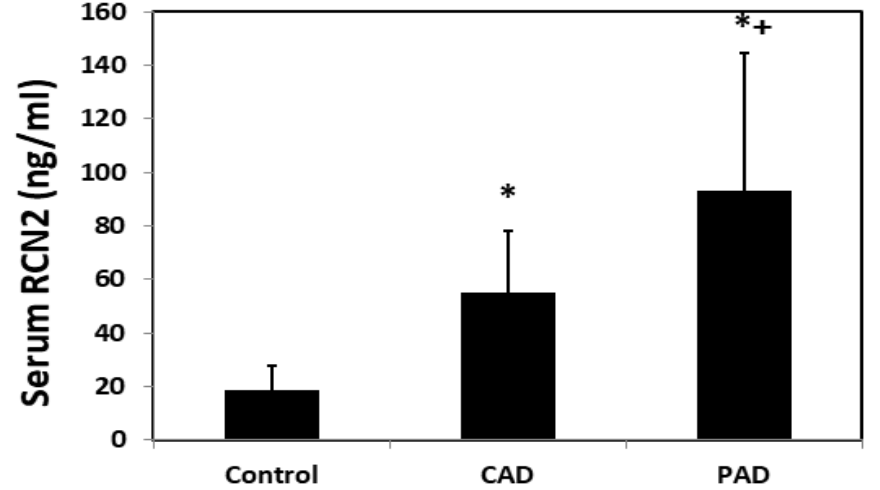
Figure 4. Serum RCN2 levels of patients with coronary artery disease (CAD) or peripheral artery disease (PAD) compared with healthy individuals. Results are means ± SD of 20 to 34 subjects per group. * p < 0.05 vs. healthy individuals. + p < 0.05 vs. CAD. One-way ANOVA was performed to determine statistical significance in RCN2 levels among the groups.